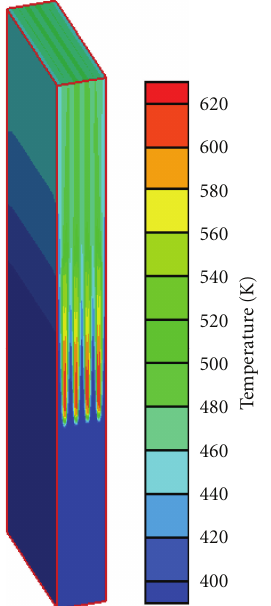
Figure 5: Temperature contour for simulation performed for REKO facility for inlet hydrogen mole fraction 2% and temperature 383 K.